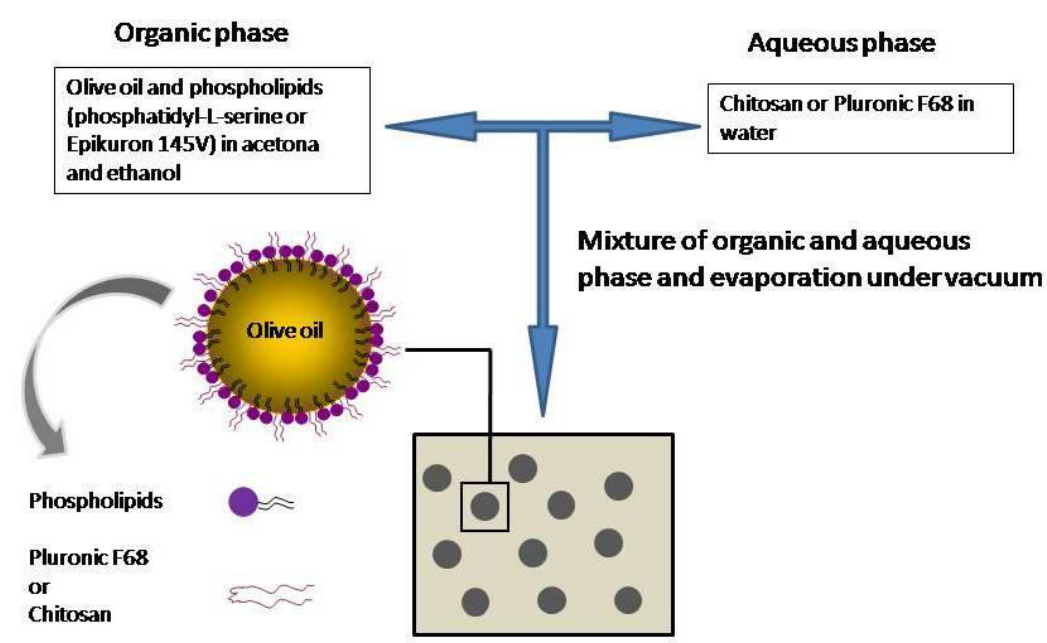
Figure 9. Scheme detailing the preparation of the